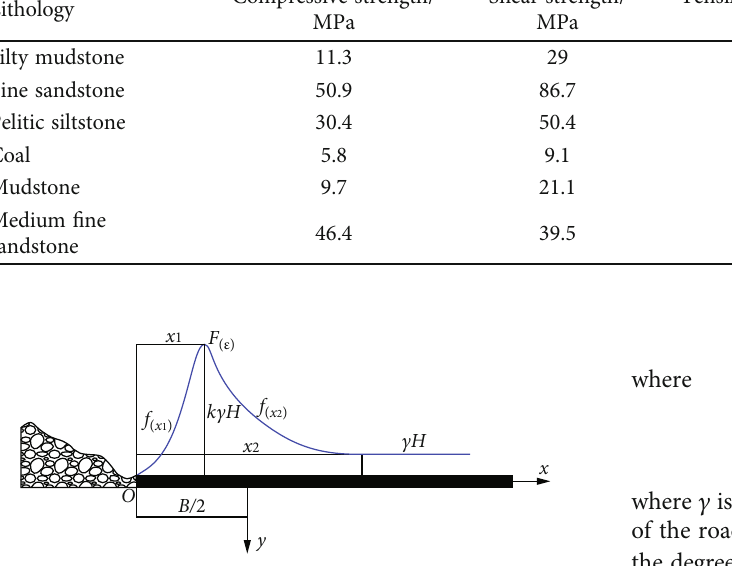
Figure 5: Vertical stress distribution in the integrated coal after working face